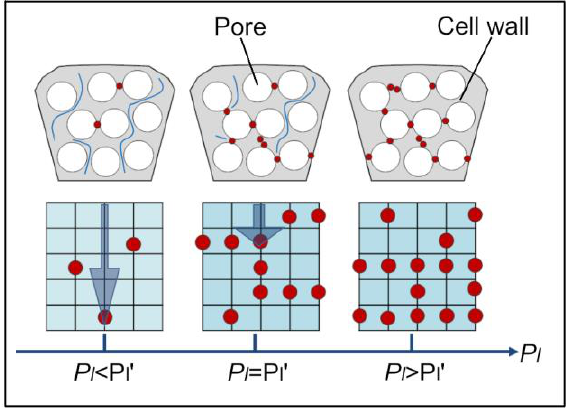
Figure 12. Schematic illustration showing percolation theory of the lattice structure. P l is the percolation probability for the lattice structure. P l ′ is the percolation threshold of the lattice structure. The red circles indicate the aggregated parts.